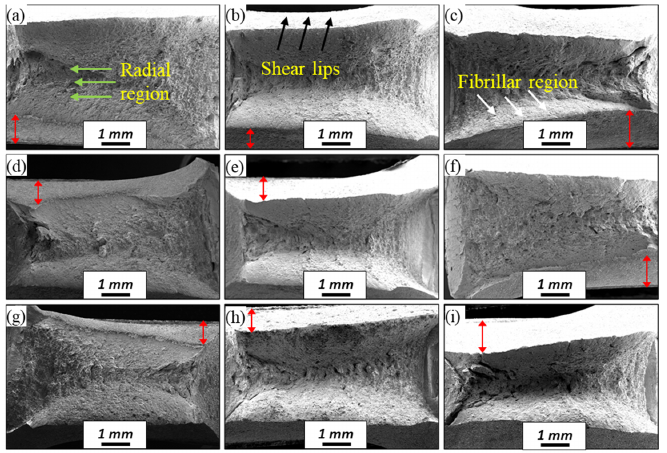
Figure 6. Macroscopic fractography of the low-temperature impact specimens with different quenching and tempering processes: ( a ) Q850 °C + T580 °C, ( b ) Q850 °C + T620 °C, ( c ) Q850 °C + T660 °C, ( d ) Q900 °C + T580 °C, ( e ) Q900 °C + T620 °C, ( f ) Q900 °C + T660 °C, ( g ) Q930 °C + T580 °C, ( h ) Q930 °C + T620 °C and ( i ) Q930 °C + T660 °C.